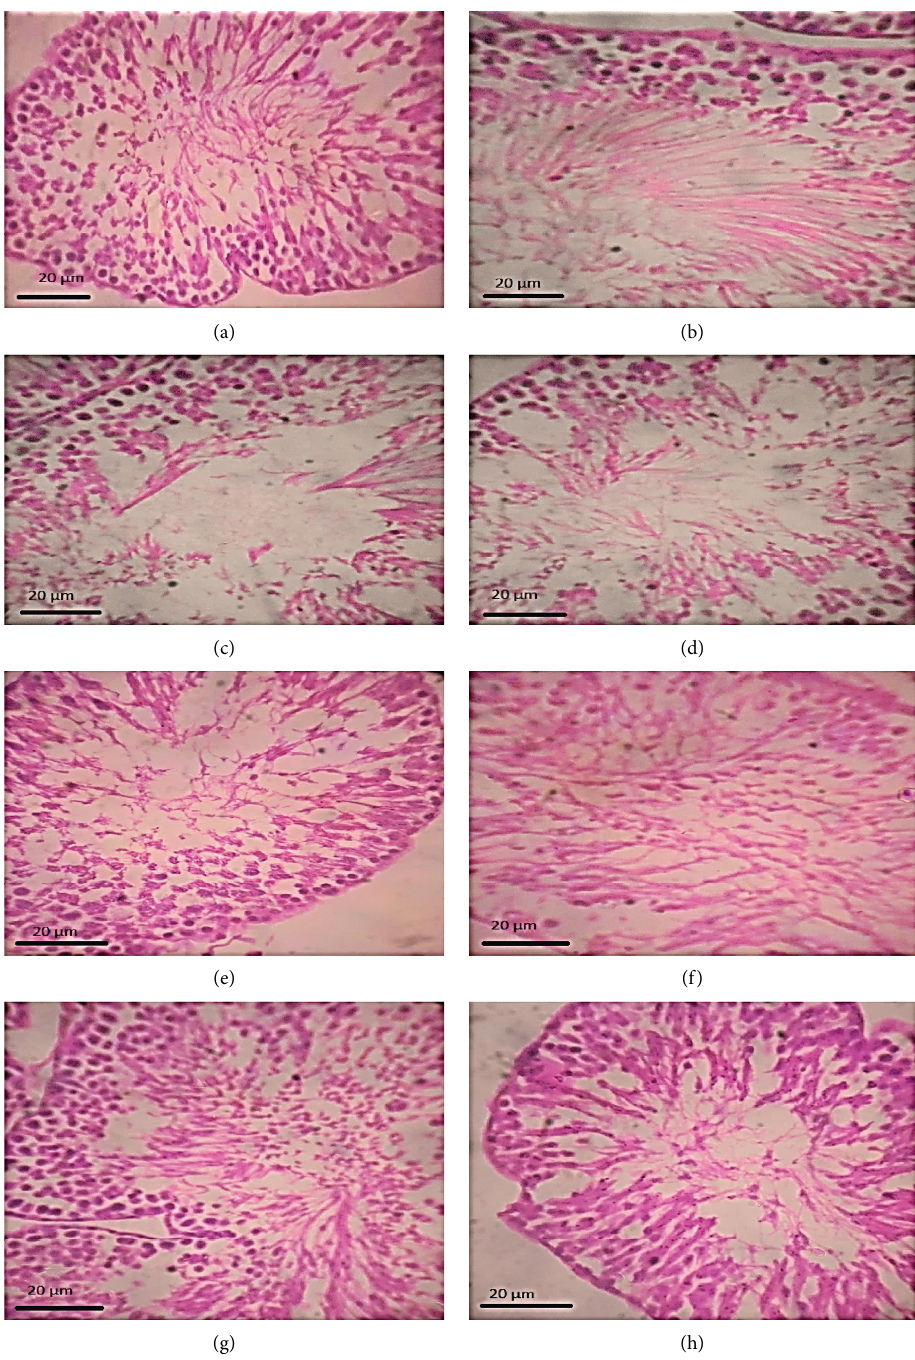
Figure 5: Photomicrograph of sections of seminiferous tubules and interstitial cells in esomeprazole (ES) and lansoprazole (LN) treated rats under magnification 100 x. (a) Control rats showed normal seminiferous tubules, (b) ES at 2.5 mg/kg/day showed oligospermia, vacuolization, and dilation/swelling of sperm cells, (c) ES at 5mg/kg/day showed dilation of seminiferous tubules, (d) esomeprazole at 10mg/kg/day showed swelling of Leydig cells, (e) control rats showed normal seminiferous tubules, (f) LN at 2.5mg/kg/day showed oligospermia, vacuolization, dilation/swelling of sperm cells, and degenerated seminiferous tubules, (g) LN at 5mg/kg/day showed dilation of seminiferous tubules, oligospermia dilation/swelling of sperm cells, vacuolization, necrosis, and swelling of Leydig cells, and (h) LN at 10mg/kg/day showed vacuolization, dilation/swelling of sperm cells, and